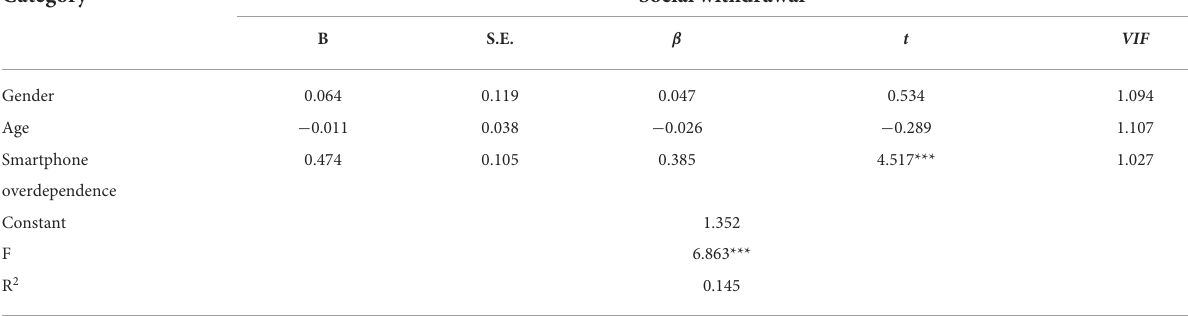
TABLE 5 Relationship between smartphone overdependence and social